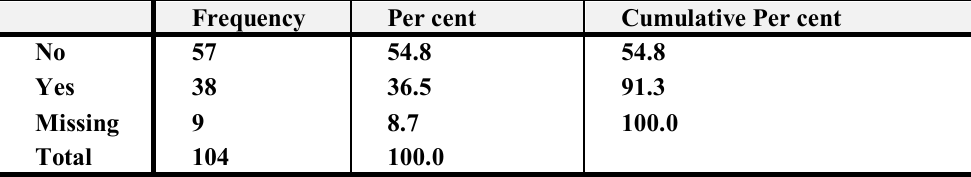
Table 4: Lenders who provided education to owners before taking out a